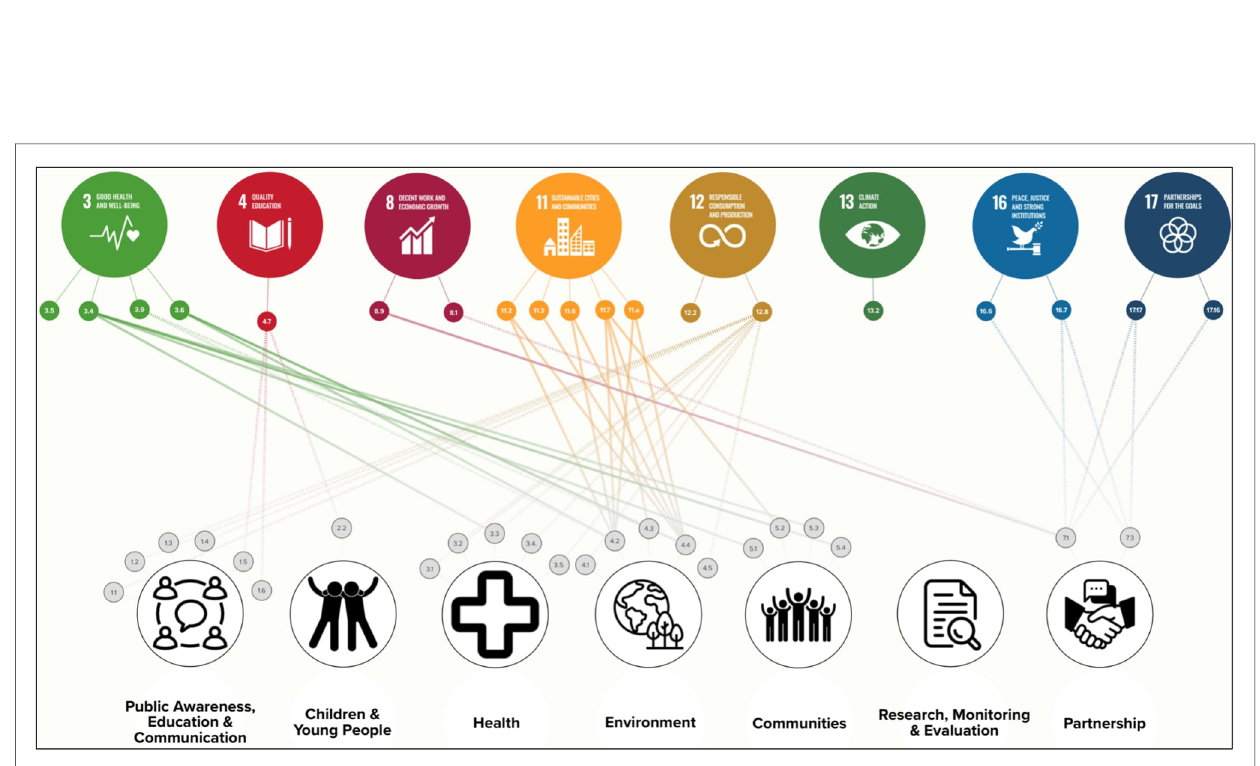
FIGURE 4 Walking related NSO ’ s and NSO targets (Top row) and their links to actions within the themes of the Get Ireland Walking Strategy and Action Plan 2017 – 2020 (bottom row) (solid line=NSO target identi fi ed as highly relevant to walking; dashed line=NSO target identi fi ed as partially relevant to walking.